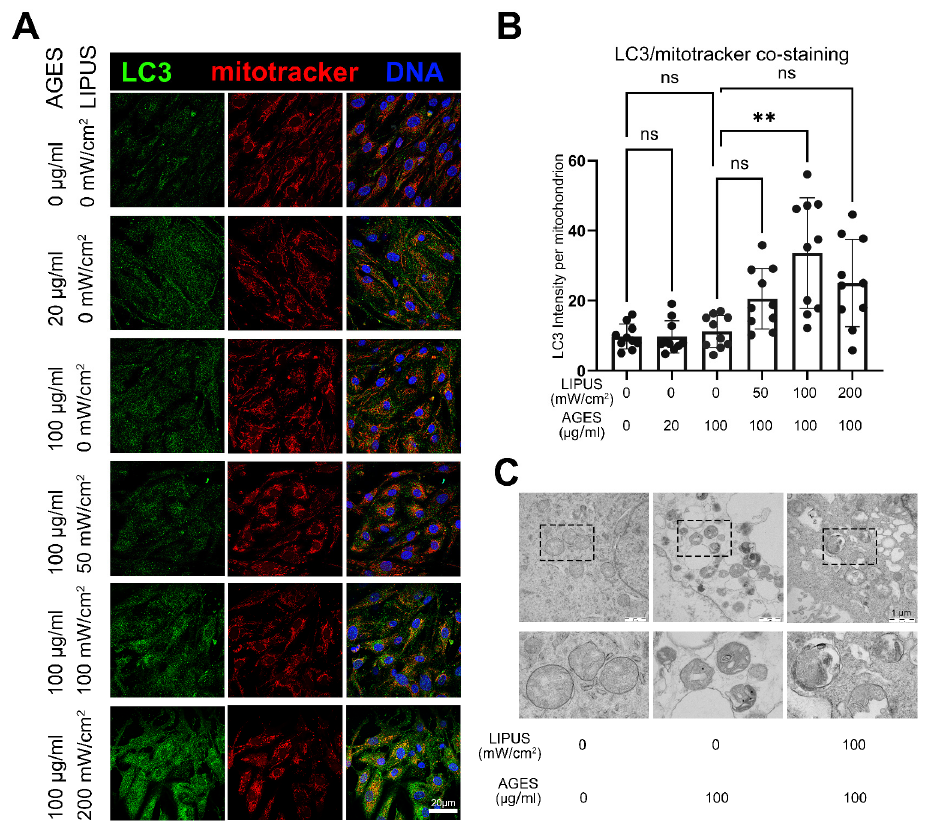
Figure 7. LIPUS treatment activated mitophagy in CCECs. ( A ) Immunofluorescence co-staining of mitotracker (red) and LC3 (green) in CCECs after different doses of LIPUS stimulation under the AGES treatment state. The scale bar represents 20 µ m. ( B ) The statistical analysis of the LC3 fluorescence intensity in mitochondrial region. n = 10 regions from 5 independent repeats. Data are shown as mean ± SD. ns, not significant; **, p < 0.01. ( C ) Transmission electron microscope image of CCECs with AGES and LIPUS treatment. The scale bar represents 1 µ m. AGES: advanced glycation end products; LIPUS: low-intensity pulsed ultrasound.